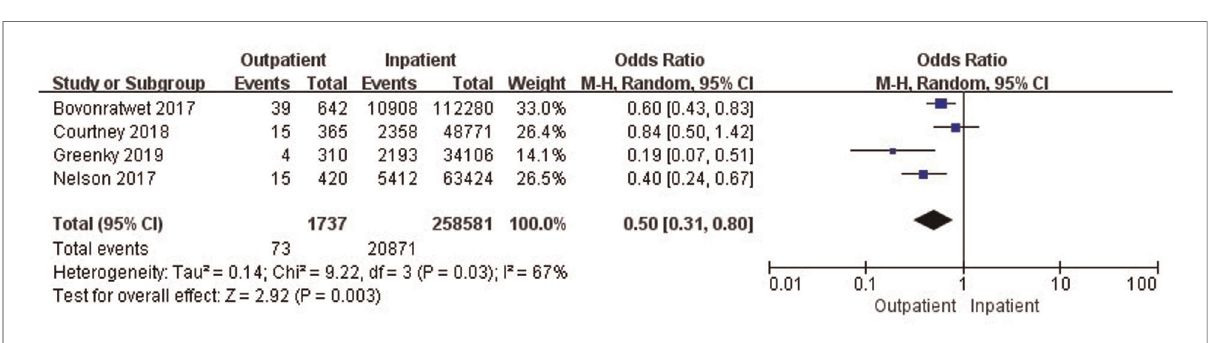
FIGURE 10 Comparison of 30-day blood transfusions between outpatient and inpatient